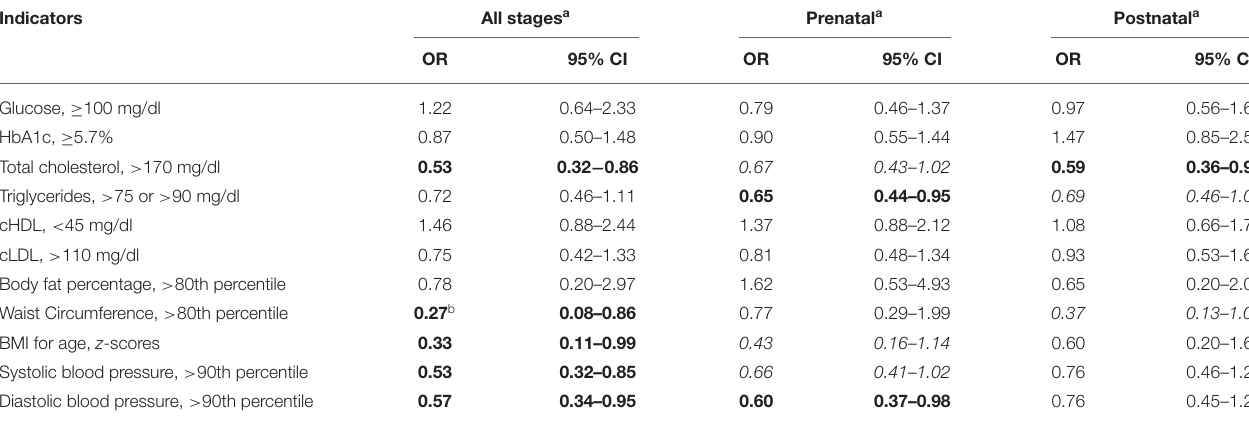
TABLE 4 | Association of higher blood lead exposure levels (above the median) and indicators of metabolic syndrome categorized according to the cutoff points. Indicators All stages a